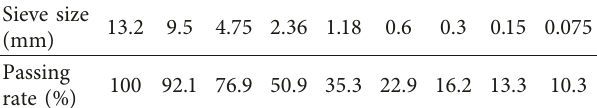
Table 1: Aggregate gradation.